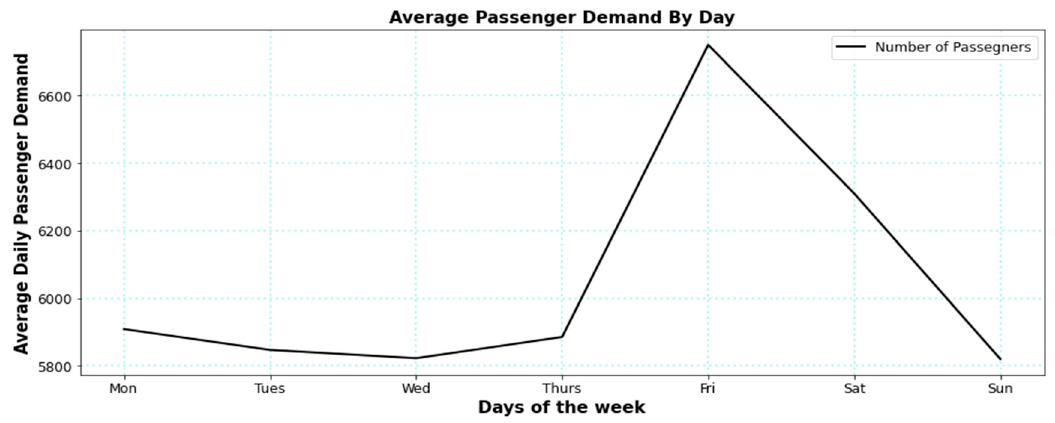
Figure 10. The wide gap between weekdays and weekends.